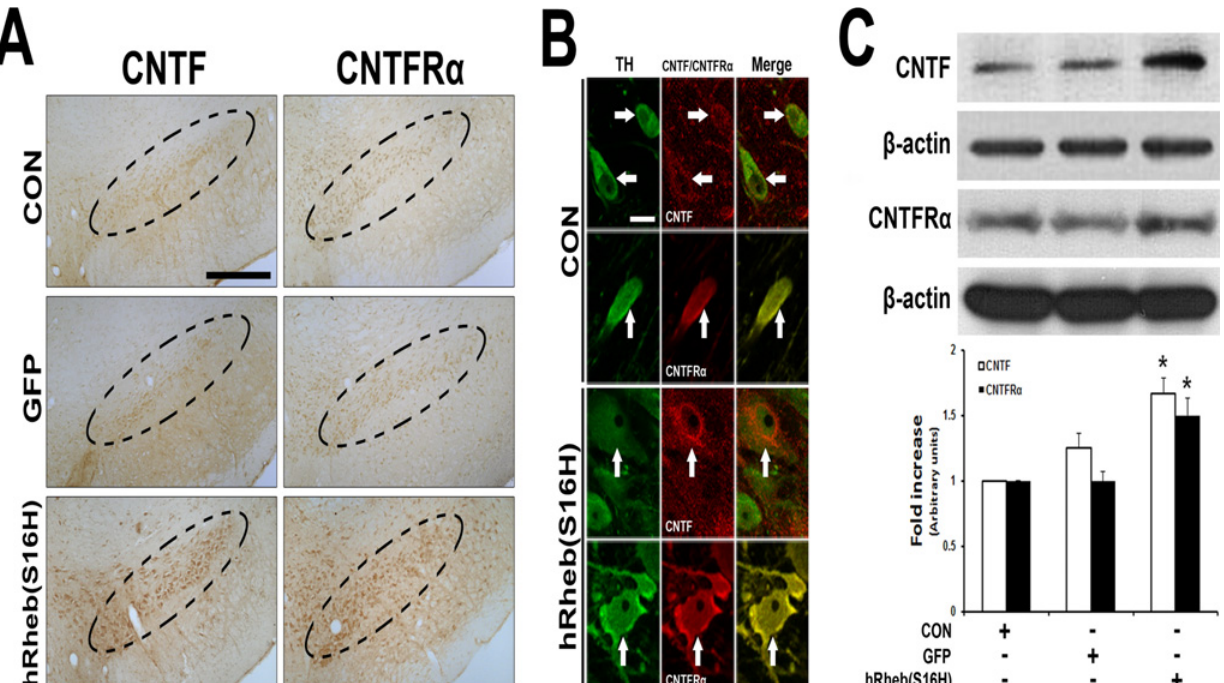
Fig 2. Induction of CNTF and CNTFR α by hRheb(S16H) transduction of dopaminergic neurons in the SN of rat brains. (A) The increase in CNTF and CNTFR α expression by hRheb(S16H) transduction of dopaminergic neurons in the SN of rat brains. Inside areas of the dotted lines indicate the SNpc. CON indicates the non-injected control side. Scale bars, 250 μ m. (B) The increases in CNTF and CNTFR α expression in dopaminergic neurons by hRheb(S16H) transduction. White arrows indicate dopaminergic neurons (TH, green) merged with CNTF or CNTFR α (red) in the SN. Note that hRheb(S16H) transduction of dopaminergic neurons apparently increased the levels of CNTF and CNTFR α expression in dopaminergic neurons. Scale bar, 20 μ m. (C) Consistent with the immunostaining results, western blotting showed increased levels of CNTF and CNTFR α in the SN 4 weeks after AAV-hRheb(S16) treatment, compared with controls. The histogram results show a quantitative analysis of density of the CNTF and CNTFR α bands normalized to β -actin for each sample. All values are expressed as mean ± SEM ( * p < 0.01, significantly different from CON; One-way ANOVA and Tukey post-hoc analysis; n = 4, each